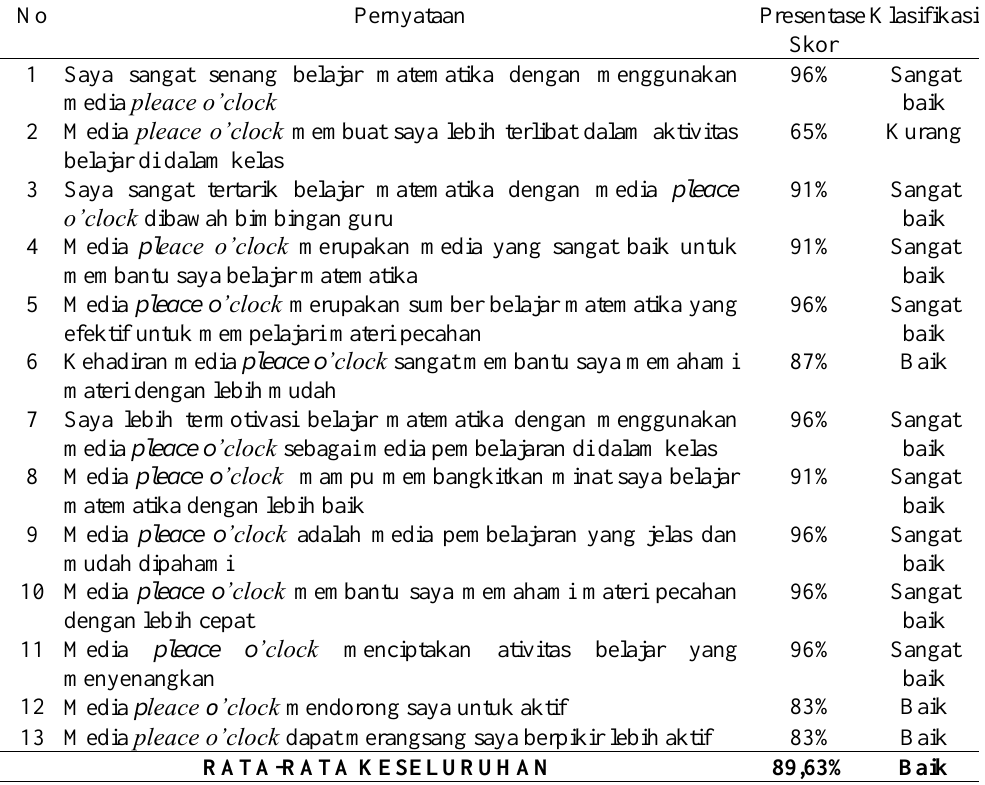
Tabel 5. Prensentase Komponen Angket Respon